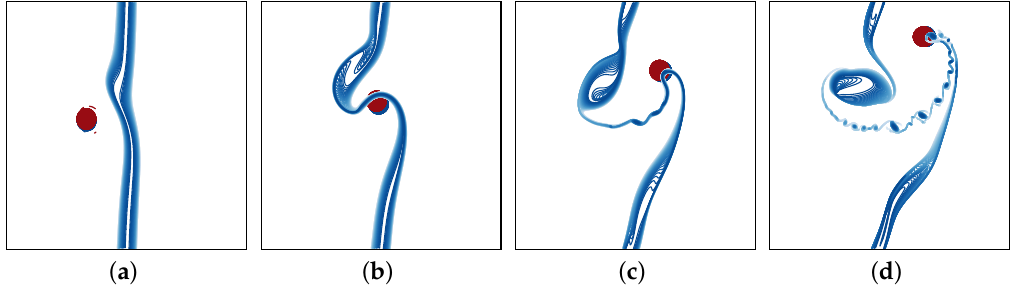
Figure 12. Case 4: effect of weakening the strength of the filament. Here Λ = 0.04, ten times smaller than in the default case 1, keeping all other parameters the same. Top view of the flow showing contours of buoyancy and PV at t = 40, 80, 120 and 160 from ( a ) to ( d ).